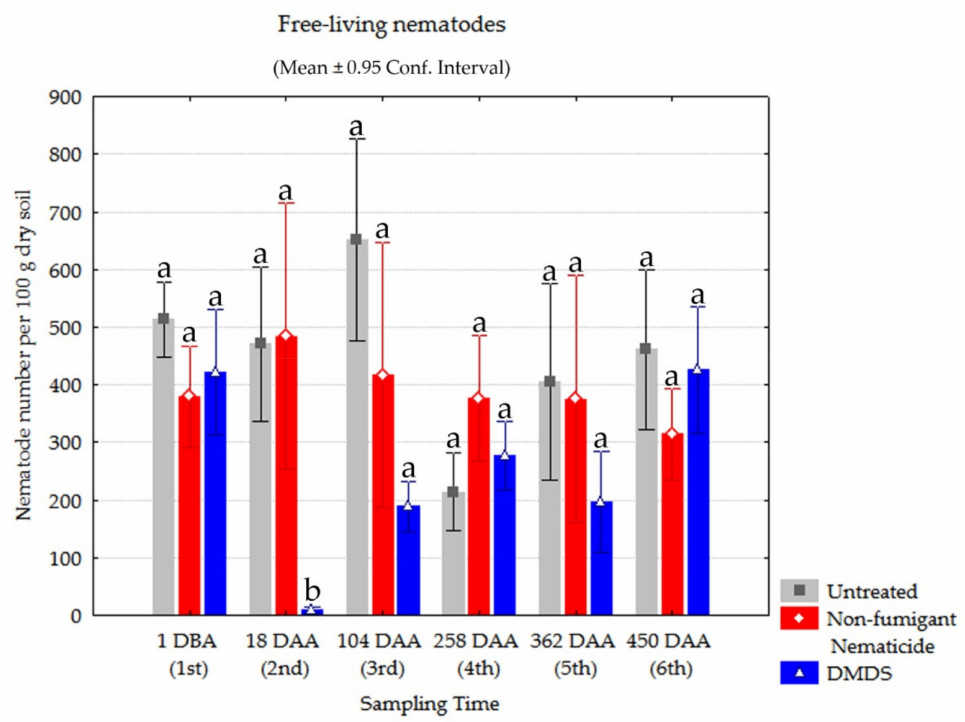
Figure 2. Dynamic of free-living nematode in the soil during the whole study period (DBA days before and DAA days after application of DMDS). Statistical significance of the differences between variants and treatments after Tukey’s test ( p < 0.05) was marked with different